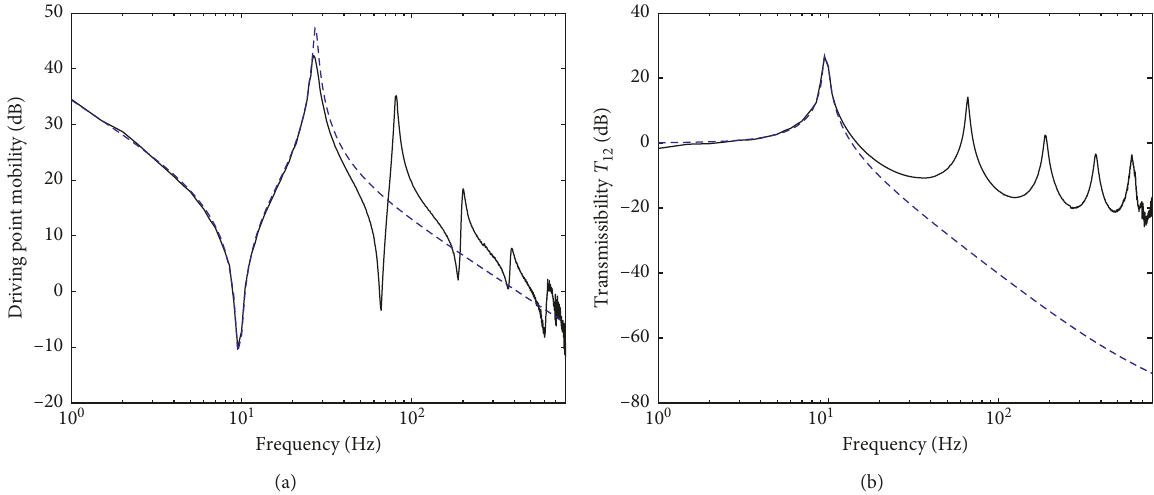
Figure 9: Measured (solid lines) responses of the flexible manipulator and their identifications (dashed) using the semidefinite two-body c LES ( k 0): (a) the driving point mobility and (b) the vibration transmissibility T 12 from the hub to the (cid:31) (cid:31)